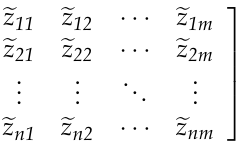
For the specific method of this study, there were 10 evaluation treatments and 5 evalua- tion indices. By referring to step (1) for EWM in Section 2.3.5, the data matrix X = of the original evaluation index was first normalized and then standardized. The stan- (cid:16) (cid:17) dardized weighting matrix (cid:101) Z = and the best and worst vector results of the (cid:101) Z ij 10 × 5 maximum and minimum values of each column were obtained after the assignment using Equation (18), as shown in Table 8.